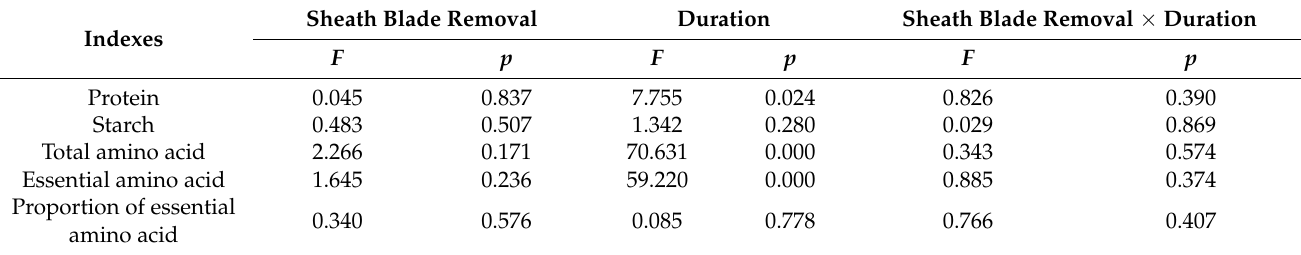
Table 2. Statistical two-way ANOVA results after Ph. violascens sheath blade removal on shoot nutritional